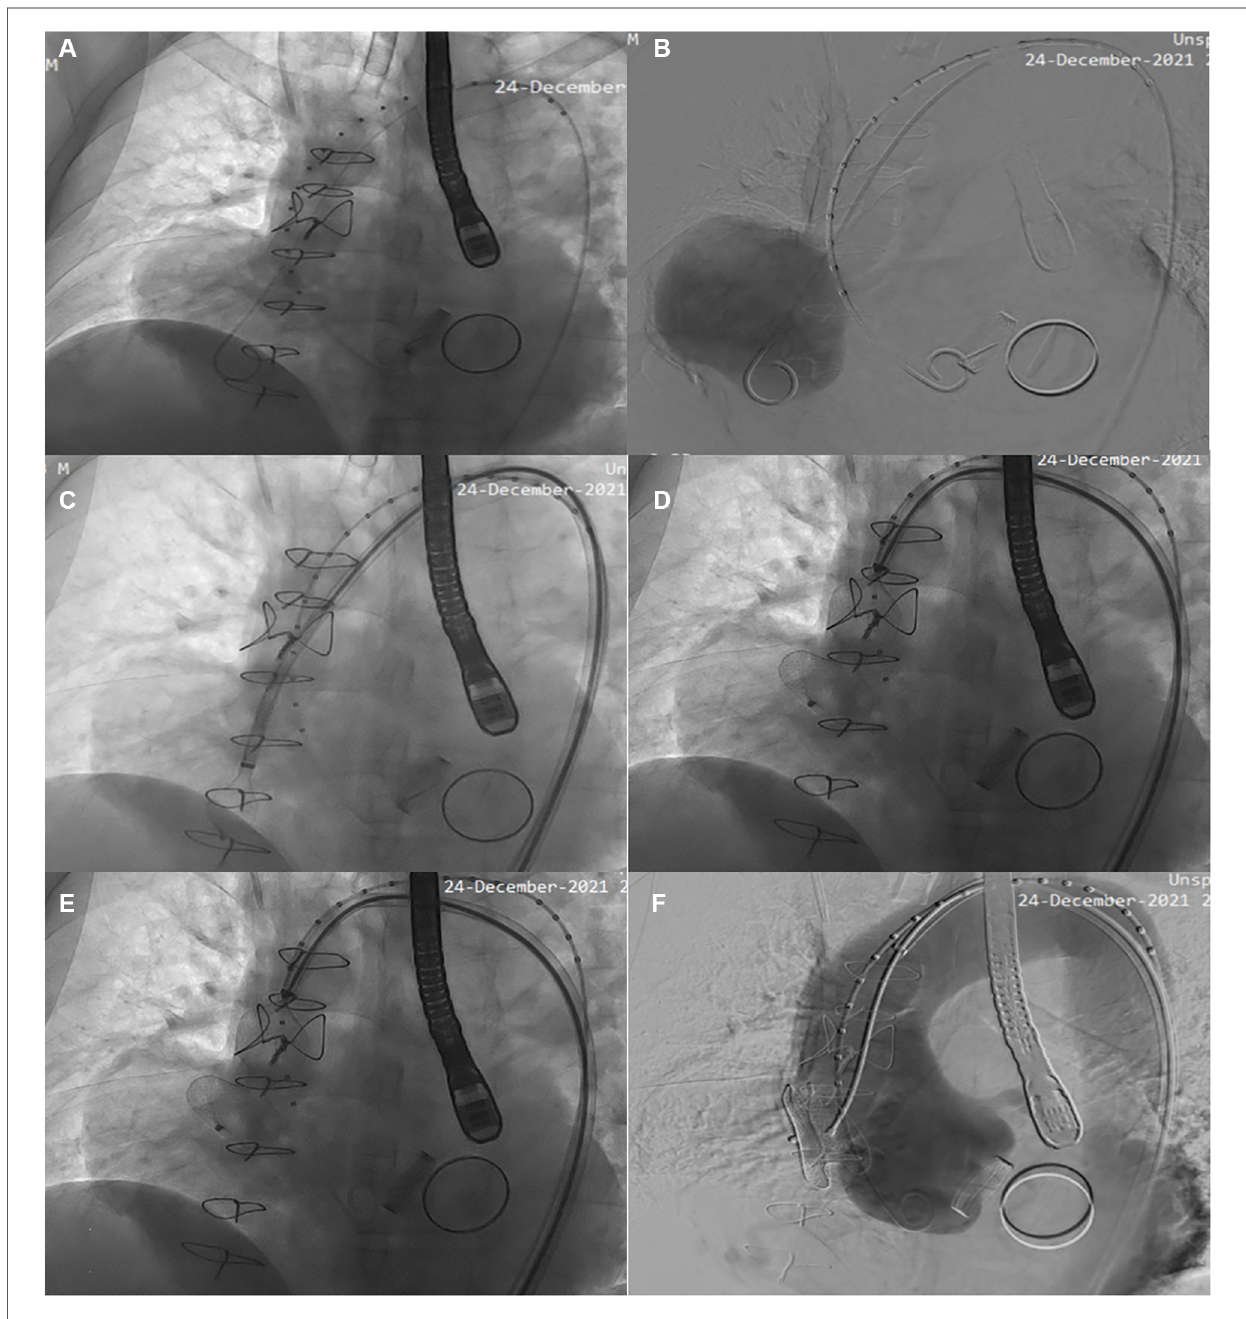
FIGURE 2 Angiography suggested that the shape of the ascending aortic sinus and the left and right coronary arteries were normal, that there was a crack at the junction of the ascending aorta, and of tumor-like deposits of a contrast agent ( A,B ). First, the blood pressure was reduced to approximately 70/40 mmHg. Then, a Lunderquist guidewire was fi xed intra-aneurysmally, and the sheath was angled and delivered through the sheath into the atrial defect occluder. Intra-aortic angiography showed a complete sealing of the breach ( C ). After gradually increasing the pressure to 90/60 and 130/ 85 mmHg, the blocker was replaced and reimaged and placed in the normal position, and then the wire was rotated to release the blocker ( D,E ). Finally, the vehicle was observed for 5 min. A complete occlusion and good aortic valve function and occluder placement were con fi rmed ( F